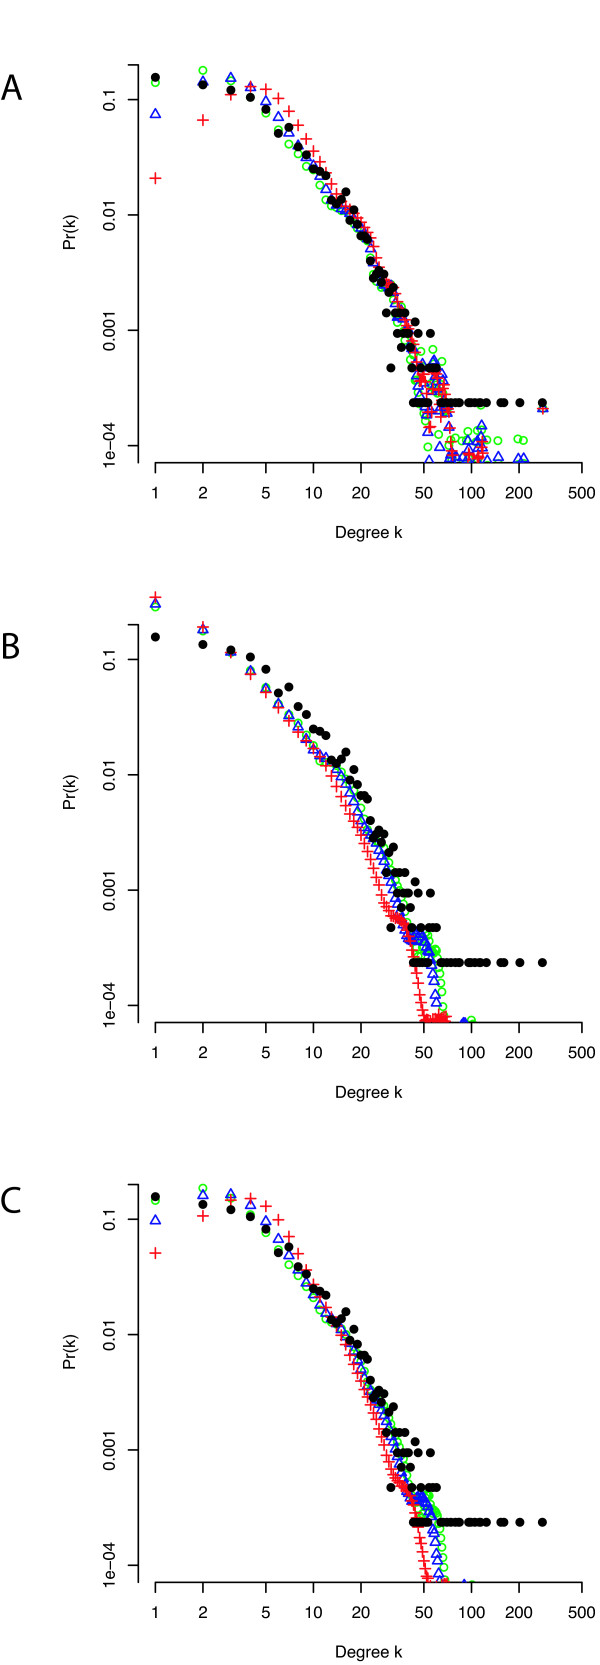
Degree distribution of noisy yeast protein interaction networks. Degree distributions for "noisy" networks with 10% (green), 20% (blue) and 40% (red) false-positives (A), false negatives (B) and rewired edges (C). In each case the degree distribution of the true network is shown in black. Shown are averages obtained from 1000 independent instances. The 95% CIs of the degree distributions overlap the symbols used to indicate the mean, i.e. the variance of Pr(k) at degree k is relatively small.